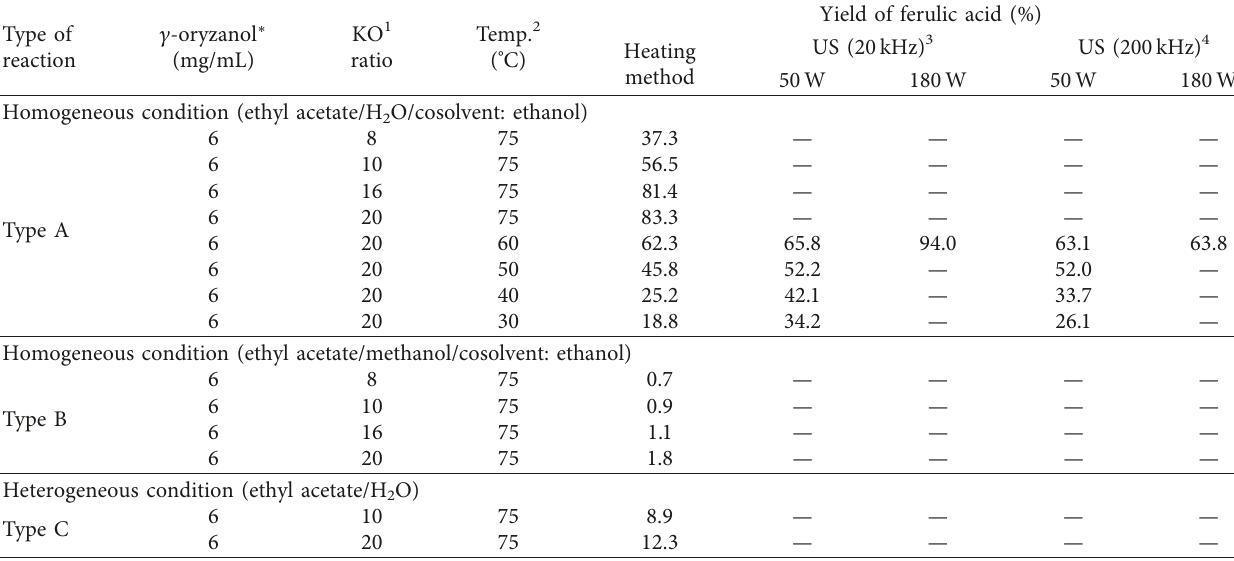
Table 1: The yields of ferulic acid from hydrolysis of c -oryzanol by heterogeneous and homogeneous systems with assistance of ultrasonic irradiation. Type of reaction Homogeneous condition (ethyl acetate/H 2 O/cosolvent: ethanol)